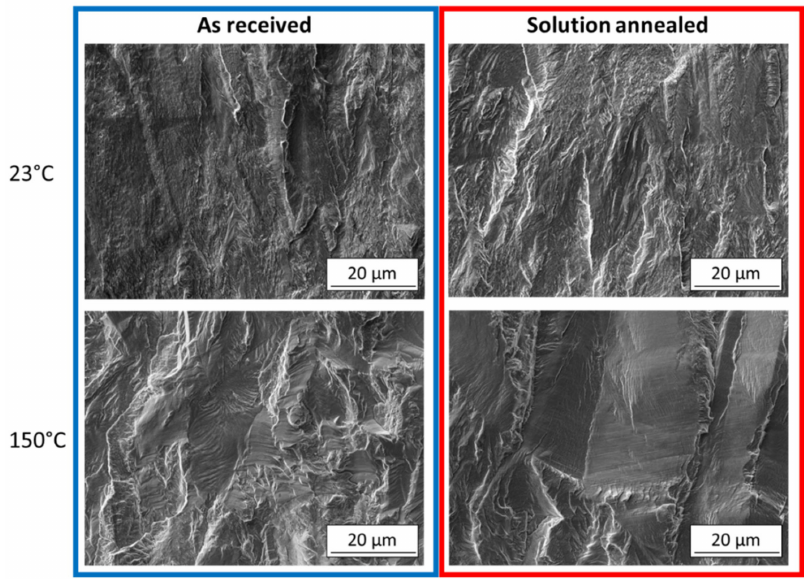
Figure 11. SEM images of fracture surfaces in the near-threshold growth area, R =